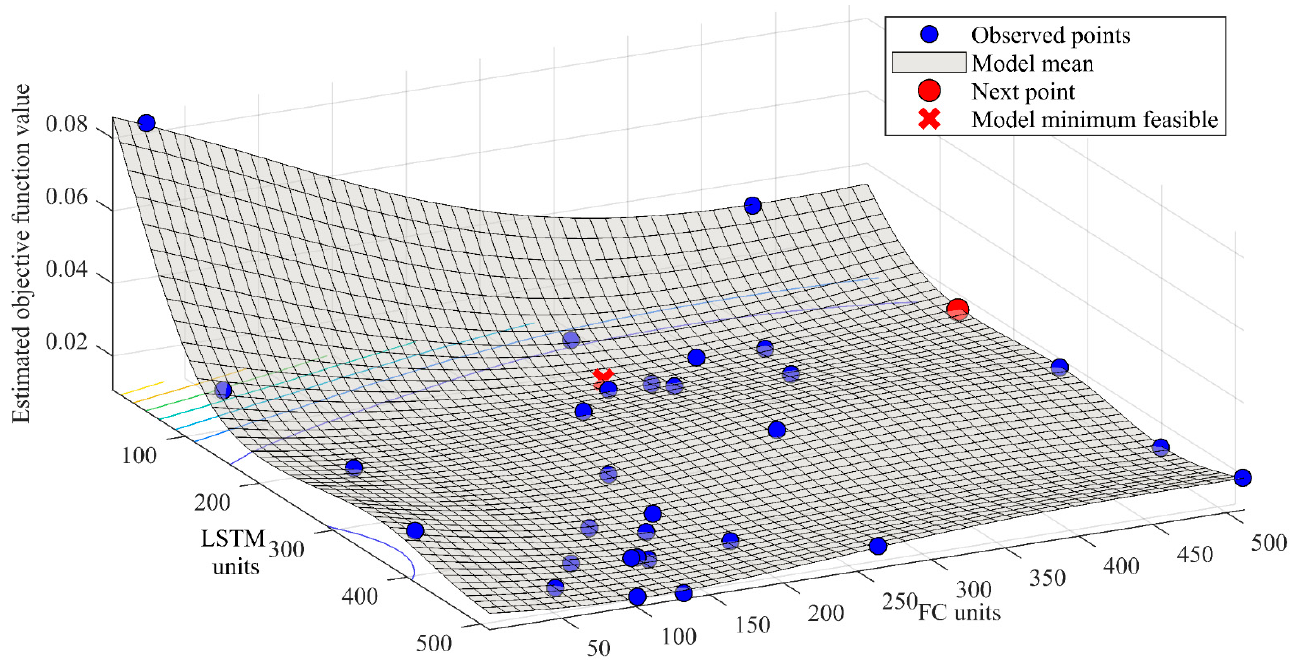
Figure 5. Bayesian search for NN model using sample window of 21.